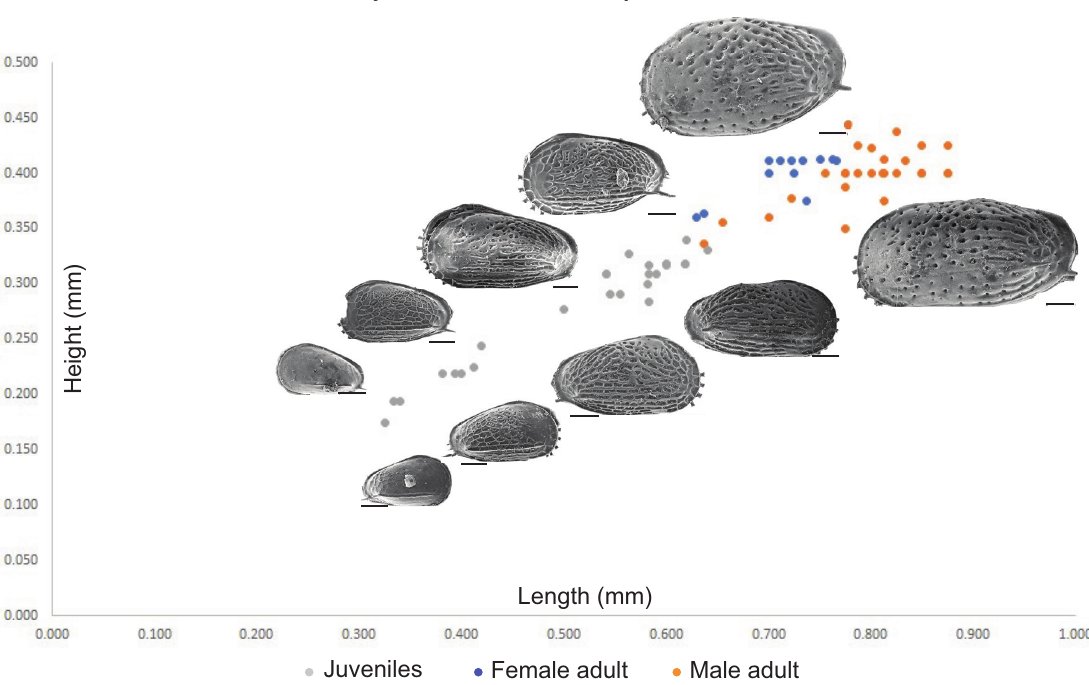
Fig. 9. Height and length scatter plot of Keijella multisulcus Whatley & Zhao, 1988 found at the whale- fall excavation site in Samut Sakhon Province, north of the Gulf of Thailand. Scale bars = 0.1